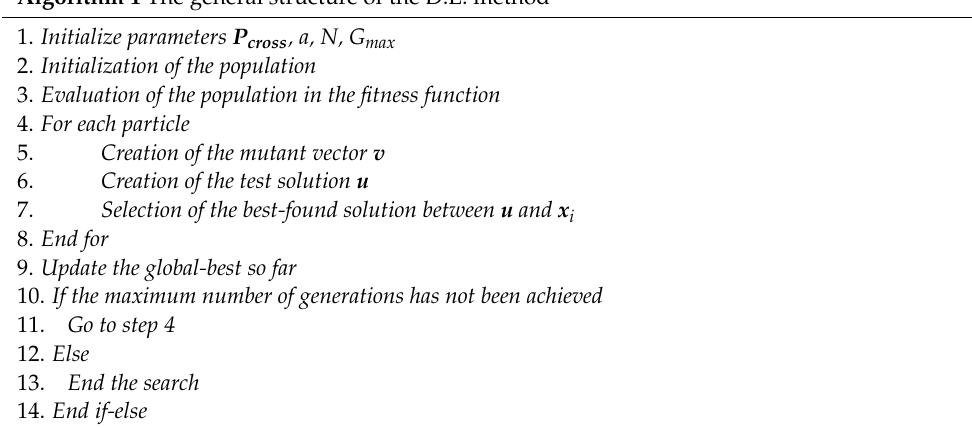
Algorithm 1 The general structure of the D.E. method